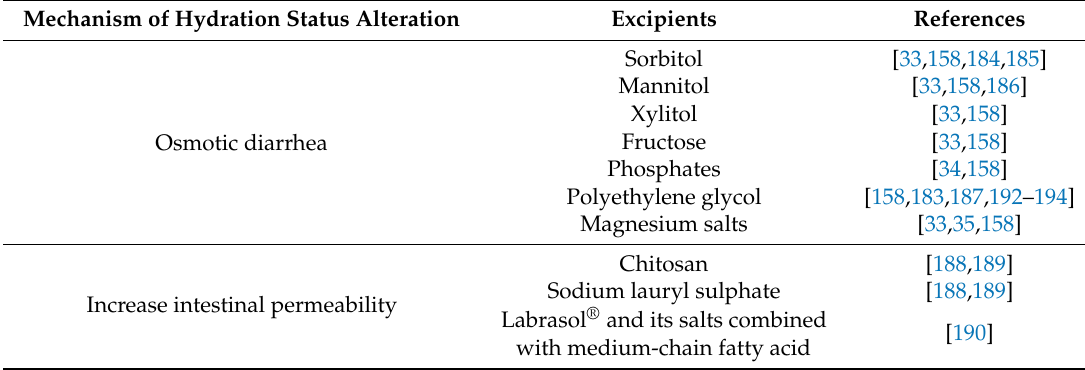
Table 2. Summary of mechanisms and excipients that induce alterations in the hydration status. Mechanism of Hydration Status